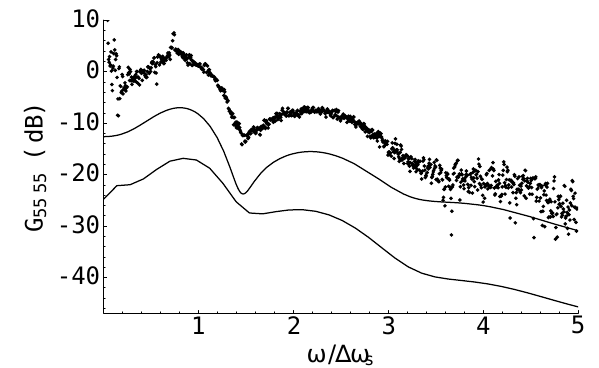
FIG. 9. Beam transfer function G 55 55 of a fully stretched single-bunch beam in the VUV ring. The data points are the beam response function T 55 55 measured at 13 mA approxi- mating G 55 55 ; the middle trace is calculated using a method derived from Krinsky and Wang’s [15] expression for their beam transfer function F mn (cid:1) 2 G mn (cid:3) k (see the text); the lower trace is calculated using the method described in Sec. III. The vertical scale has an arbitrary scale factor and the horizontal scale of the first and third traces ( Dv s ) was adjusted 20% to fit the second trace. Machine parameters are given in Table I.